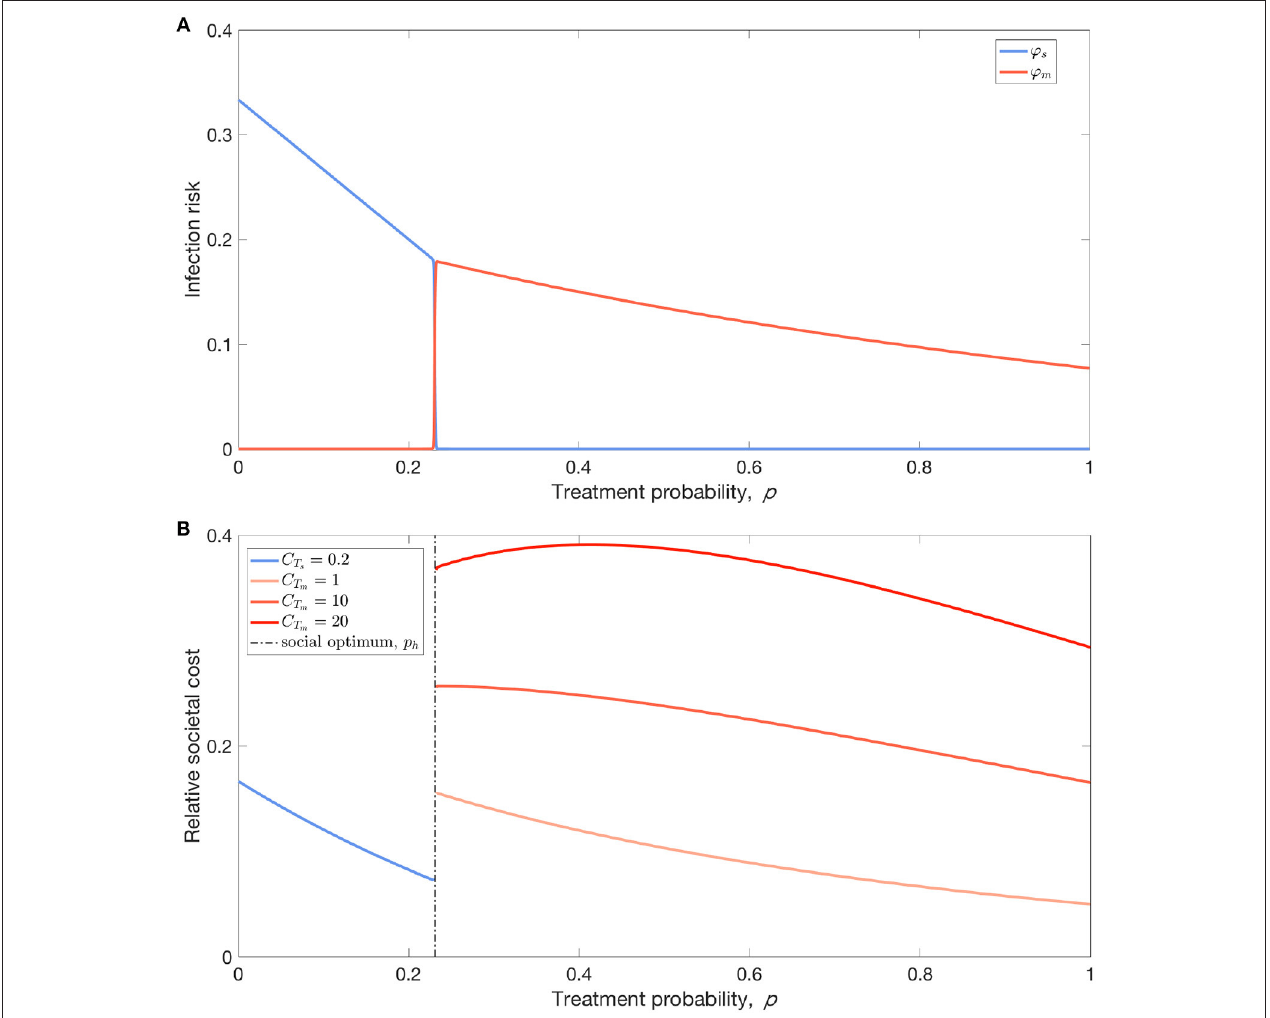
FIGURE 3 | Cost-benefit analysis of antibiotic usage. (A) From the perspective of susceptible individuals, their infection risk reduces with increasing treatment probability (coverage) p , but there exists a threshold of treatment coverage, p h , above which the risk of infection almost exclusively comes from resistant strain instead of sensitive stain. (B) Accounting for the differing costs of treating patients infected with sensitive and resistant strains, the threshold p h corresponds to the social optimum of antibiotic usage: the total societal disease burden is decreasing with p for p < p h , but followed by a surge in the total cost of infection due to resistance. Parameters: (A,B) b = 0.1, β s = 0.3, β m = 0.26, γ 0 s = γ 0 m = 0.1, γ t s = 0.3, γ t m = 0.2, ǫ s = 1, ǫ m = 0, θ = 0.2, µ s = µ m = 10 − 6 , (B) relative social burden of the disease: